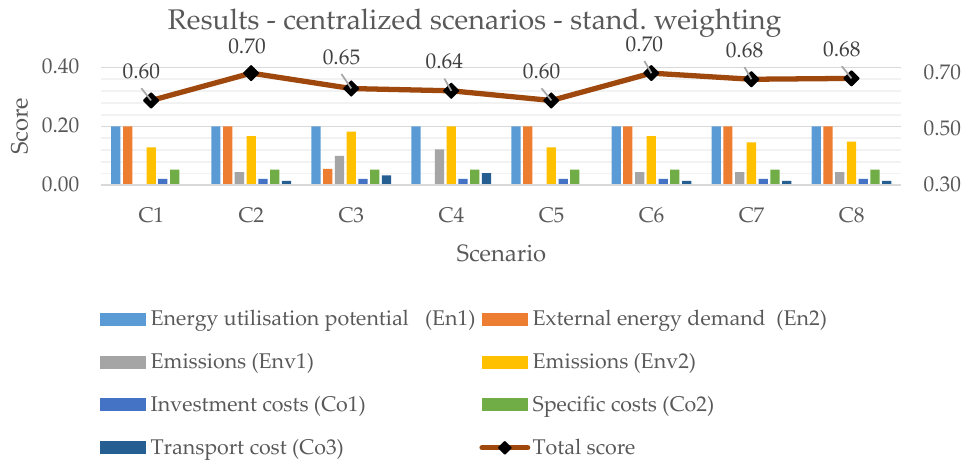
Figure 11. Overall results with the standard weighting for decentralized scenarios (2a,b). The score (left y-axis) of each evaluation criteria (En1, En2, Env1, Env2, Co1, Co2, and Co3) is shown for all scenarios (C1–C8). The total score (right y-axis) for each scenario is shown by line above the evaluation criteria bars.